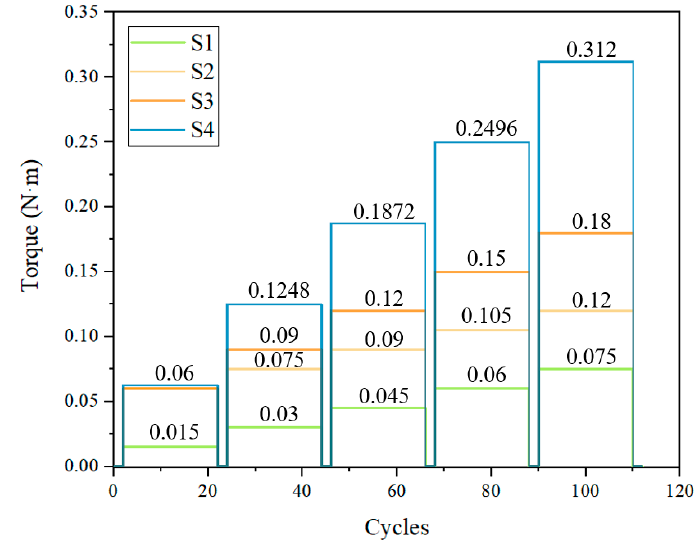
Figure 9. Torques used in the experiment.